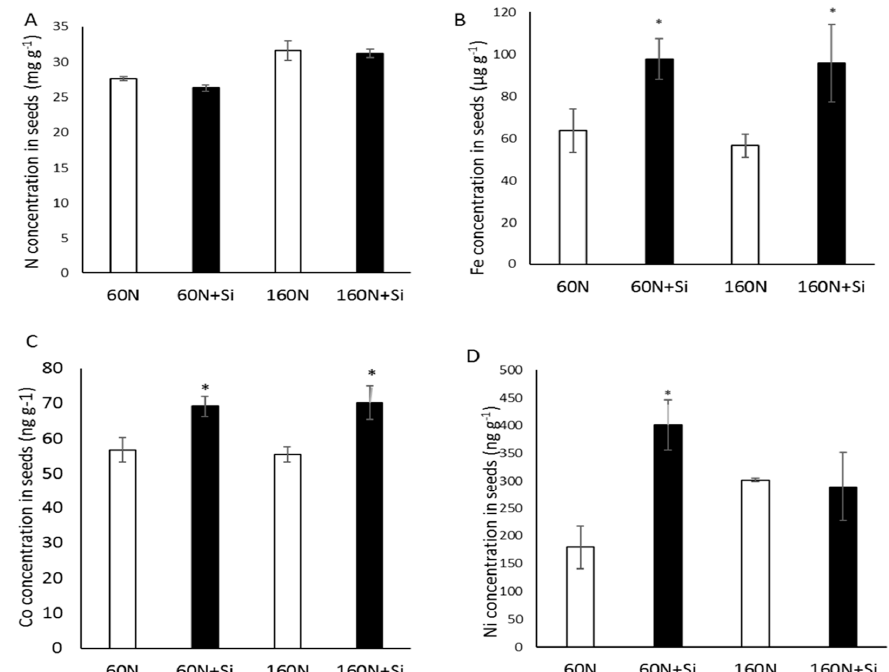
Figure 4. Nitrogen ( A ), Iron ( B ), Cobalt ( C ) and Nickel ( D ) concentrations in mature seeds of plants were compared to their respective controls. * indicates a significant di ff erence at p ≤